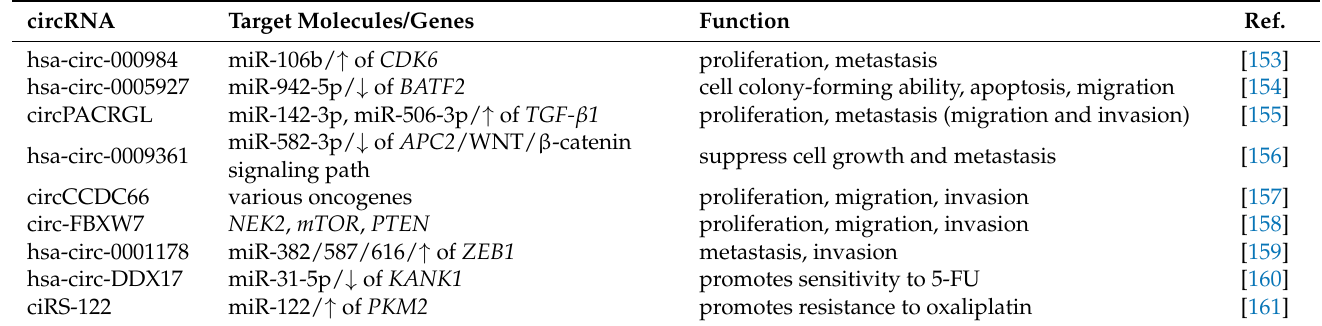
Table 7. List of circRNAs relevant for CRC progression and clinical/biological features (not all have been studied in liquid